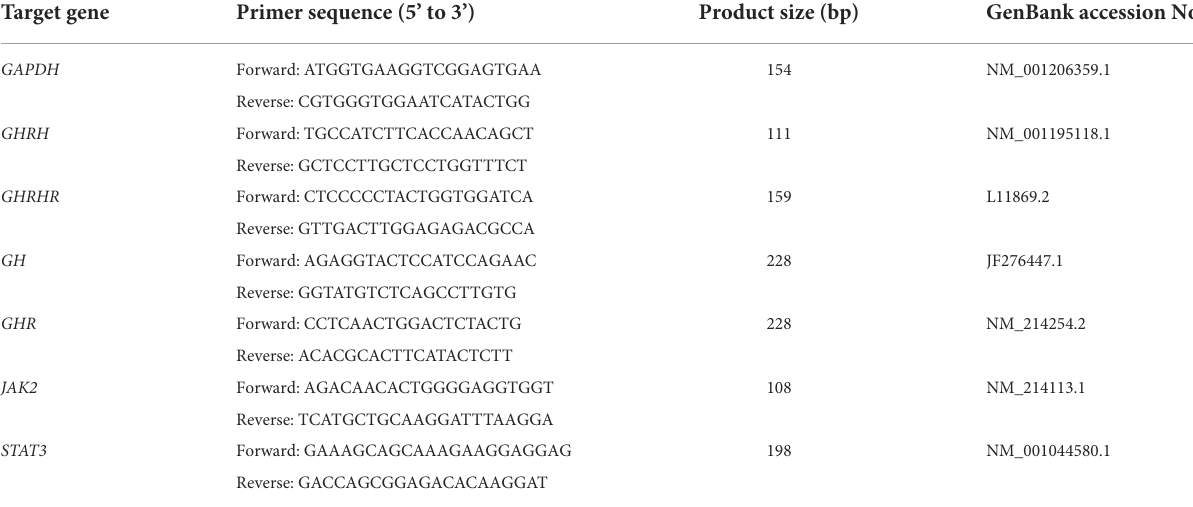
TABLE 2 Sequence of primers for real-time